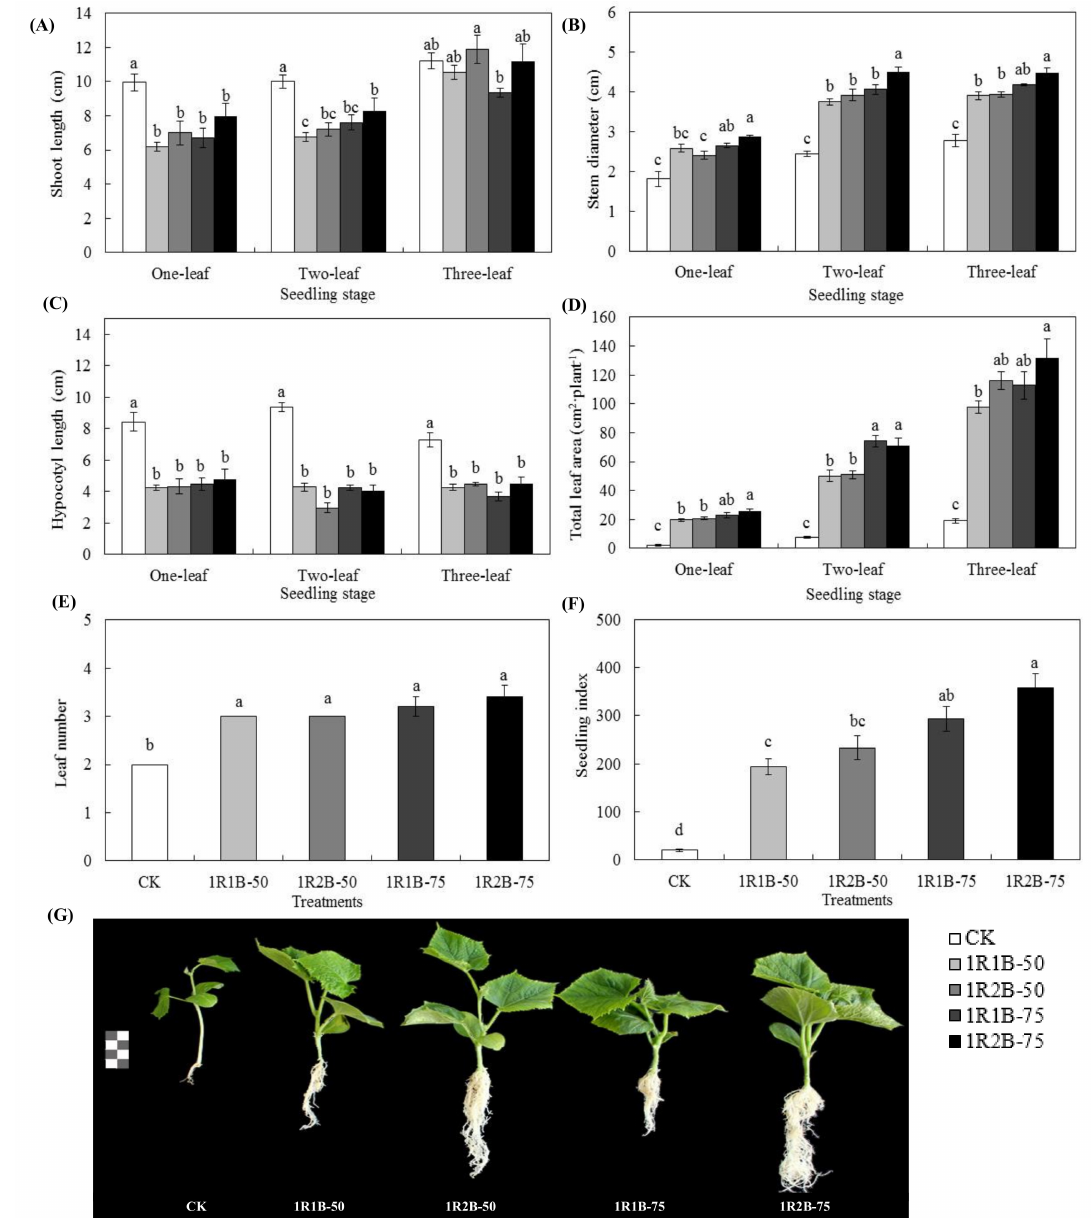
Figure 3. Effectsofblueandredlight-emittingdiodes(LED)light(RB)ratioandintensityofsupplemental light on morphological parameters of cucumber seedlings under extremely low irradiance, including shoot length ( A ), stem diameter ( B ), hypocotyl length ( C ), total leaf area ( D ), leaf number ( E ), seedling index ( F ) and growth vigor of cucumber seedlings ( G ) in experiment 2. Different letters indicate statistically significant differences among treatments ( p ≤ 0.05). Error bars show SE ( n =